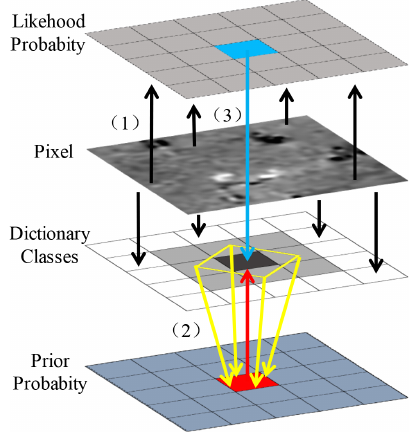
Figure 2. Diagram of Bayesian Framework.